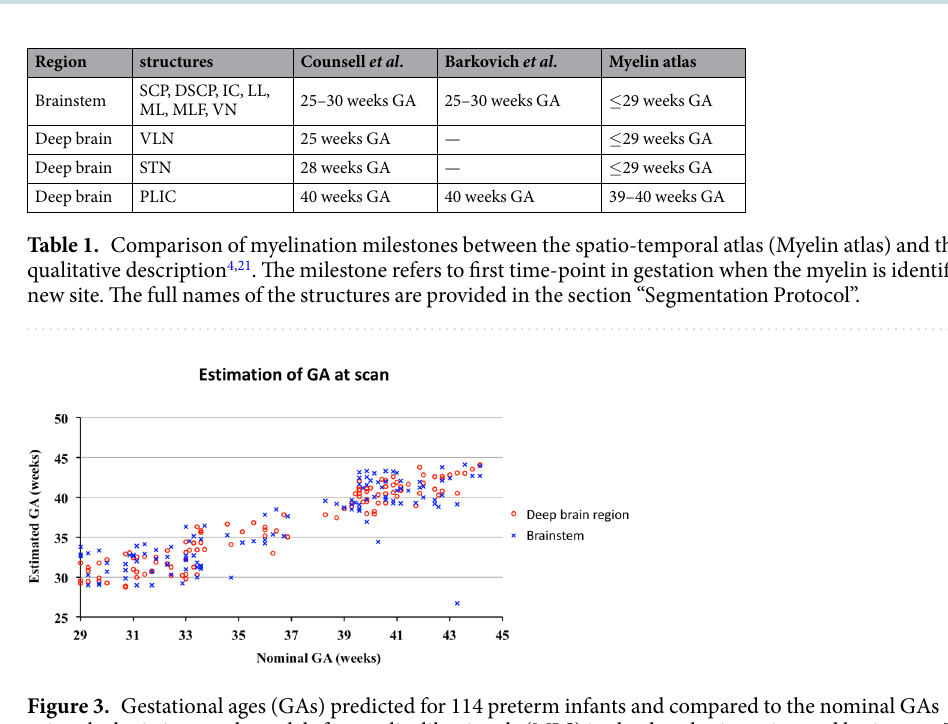
Figure 3. Gestational ages (GAs) predicted for 114 preterm infants and compared to the nominal GAs using the logistic growth models for myelin-like signals (MLS) in the deep brain region and brainstem. The predictions based on MLS in the brainstem display larger deviations from the nominal GAs than in the deep brain region. This is because most of the MLS spatio-temporal changes between 29 and 44 weeks GA